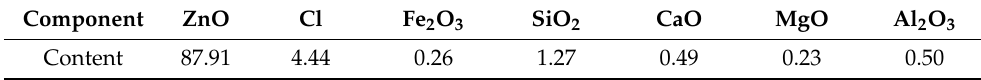
Figure 1. XRD pattern of zinc ash.